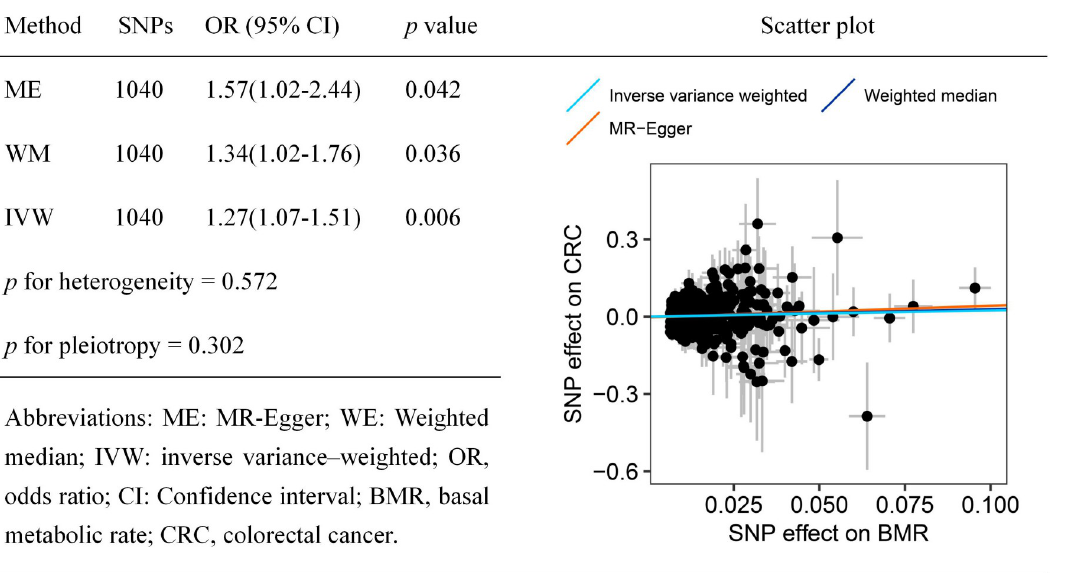
PLOS ONE | https://doi.org/10.1371/journal.pone.0273452 August 22,